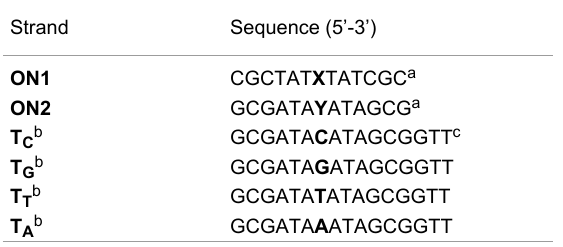
Table 1: Sequences of modified oligonucleotide and templates used in this work.